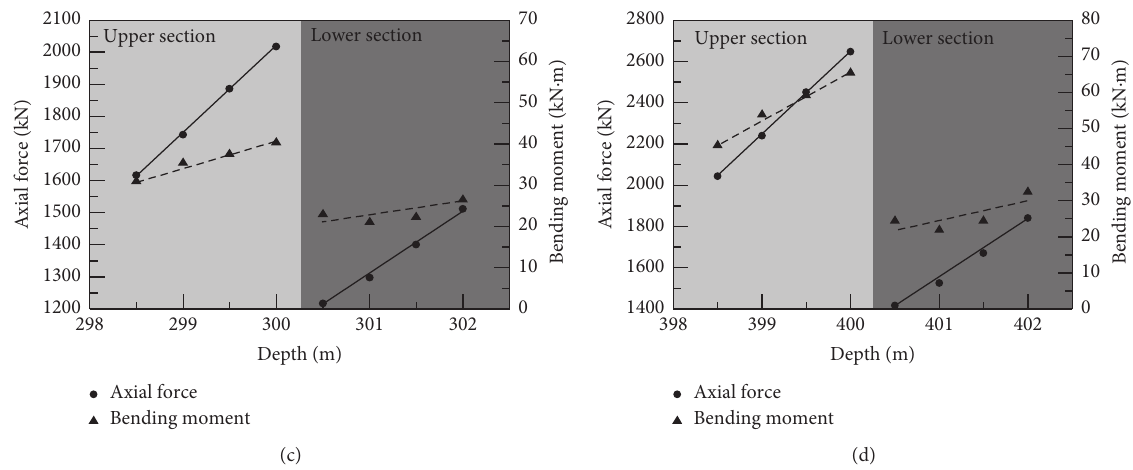
Figure 19: Numerically simulated maximum bending moment and axial force near different sections: (a) Section 1. (b) Section 2. (c) Section 3. (d) Section